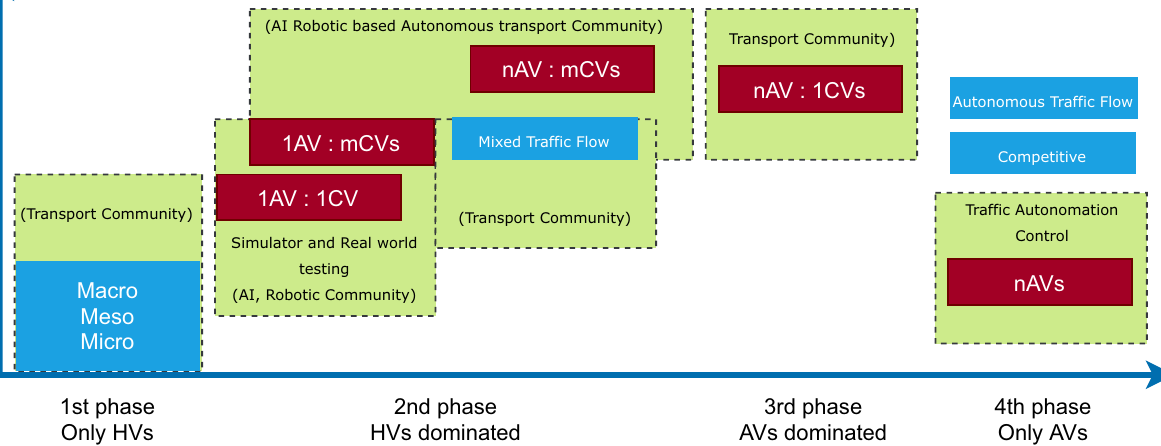
Figure 4. Time with complexity refinement at each phase (according to both researcher and manufacture aspect) 36